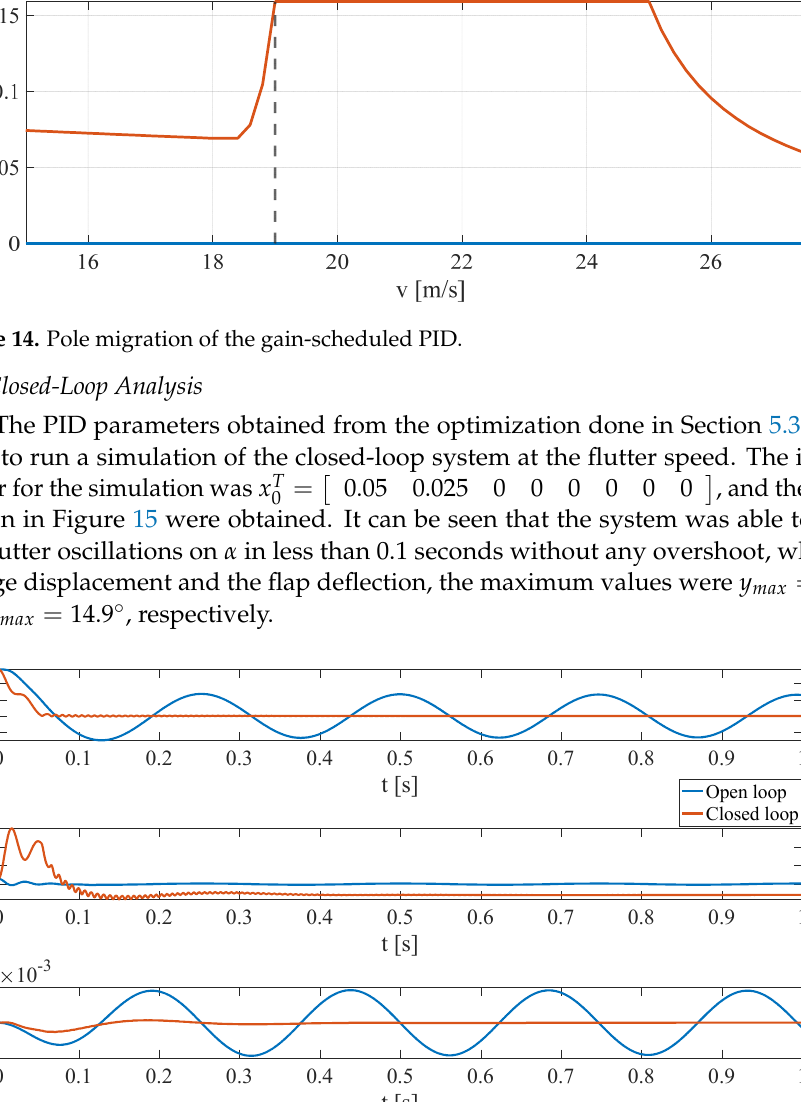
Figure 15. Closed-loop system time histories.